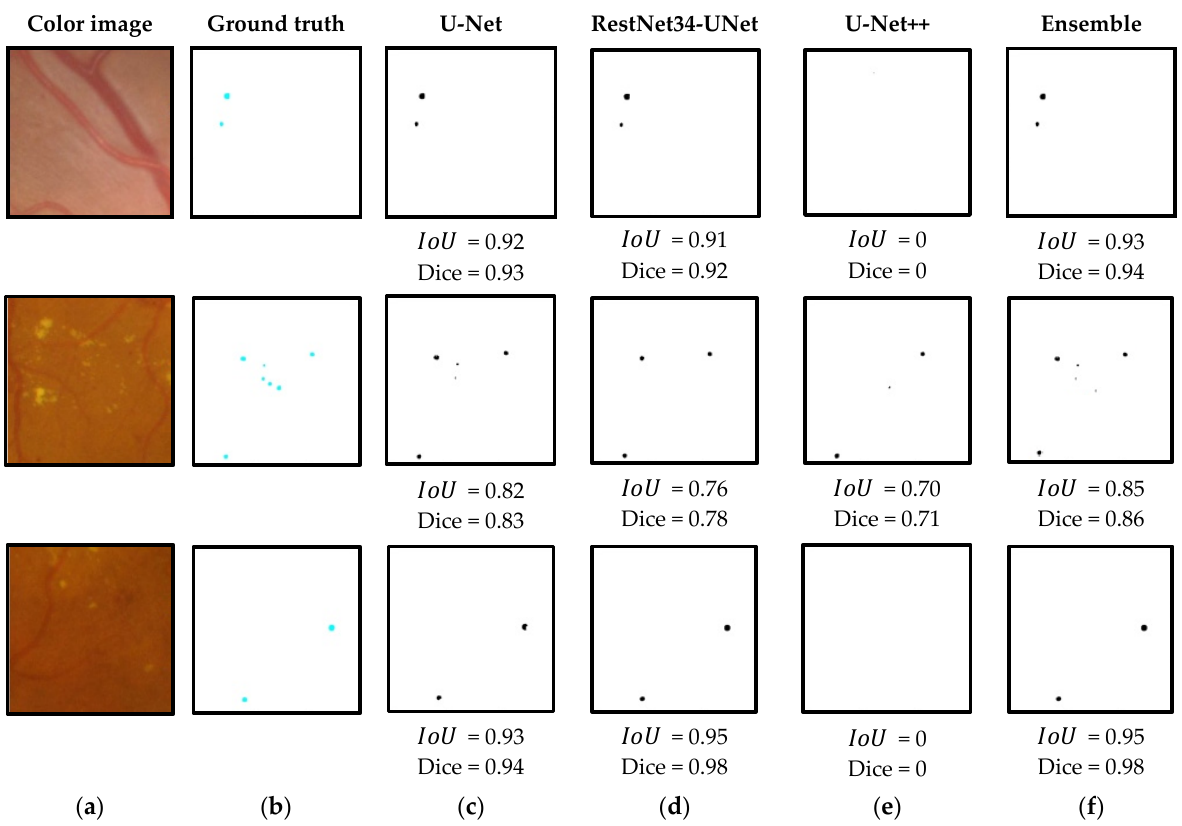
Figure 10. Visualization of the microaneurysm (MA) segmentation results of RoIs acquired from color fundus images: ( a ) original RoI, ( b ) the corresponding ground truth annotation, ( c ) MA segmentation results using the U-Net model, ( d ) MA segmentation results using the residual U-Net model, ( e ) MA segmentation results using the U-Net++ model and ( f ) MA segmentation results using the ensemble of models.